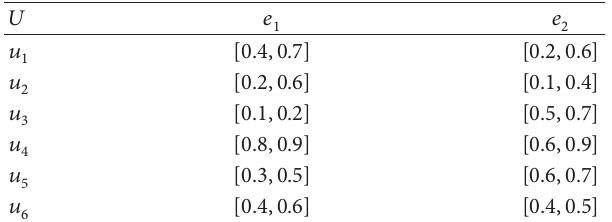
Table 1: Tabular representation of the IVF soft set A .